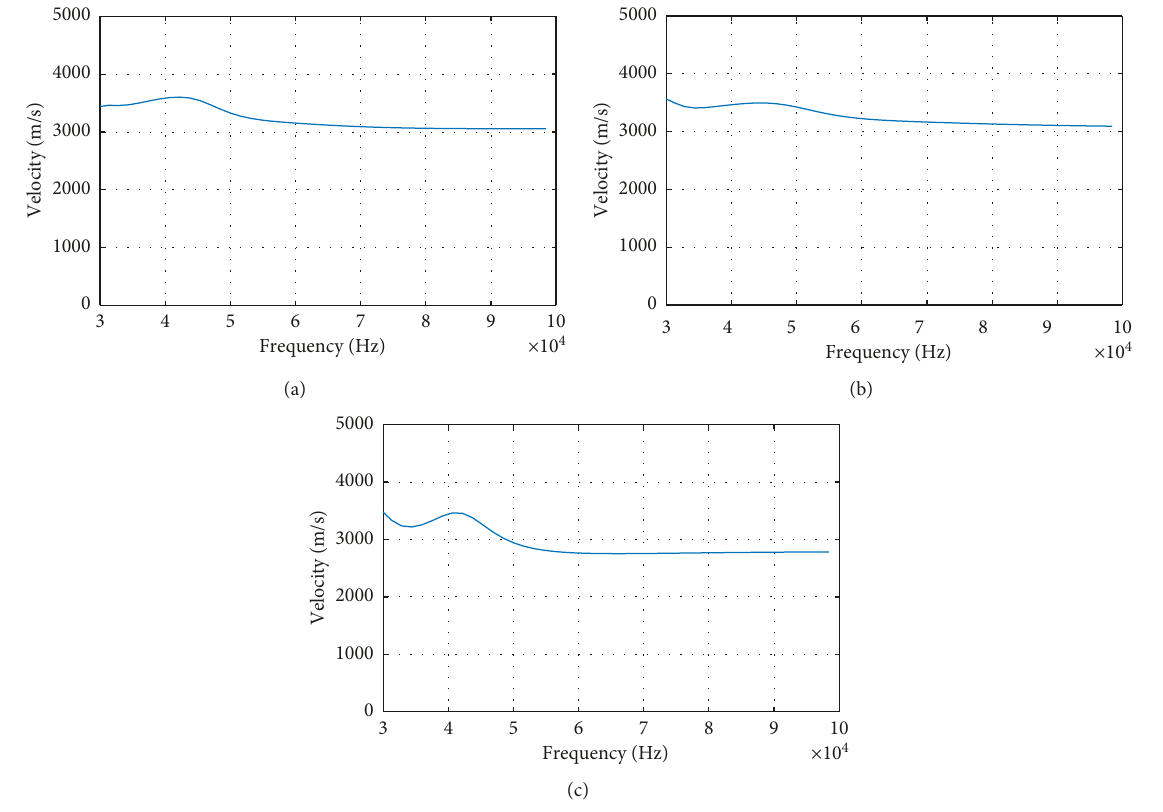
Figure 12: Frequency-dependent velocity of the ultrasonic pulse in